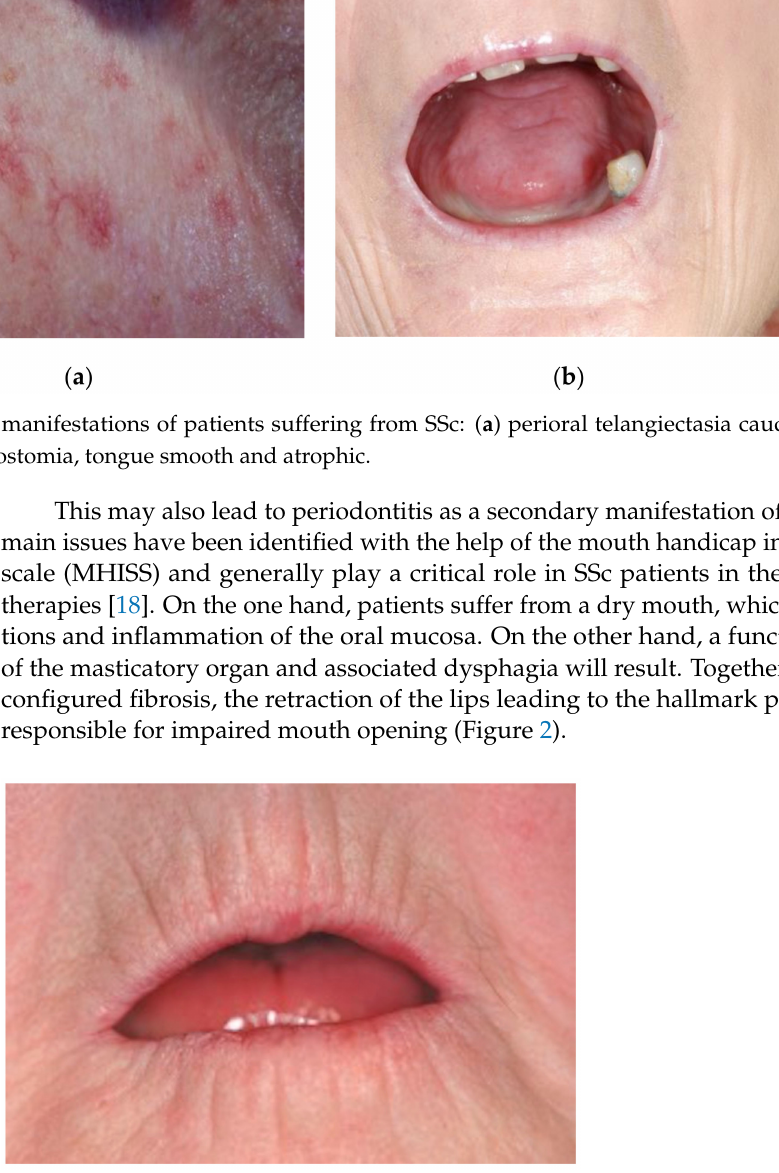
Figure 2. Patient suffering from SSc. Perioral wrinkles, microcheilia,